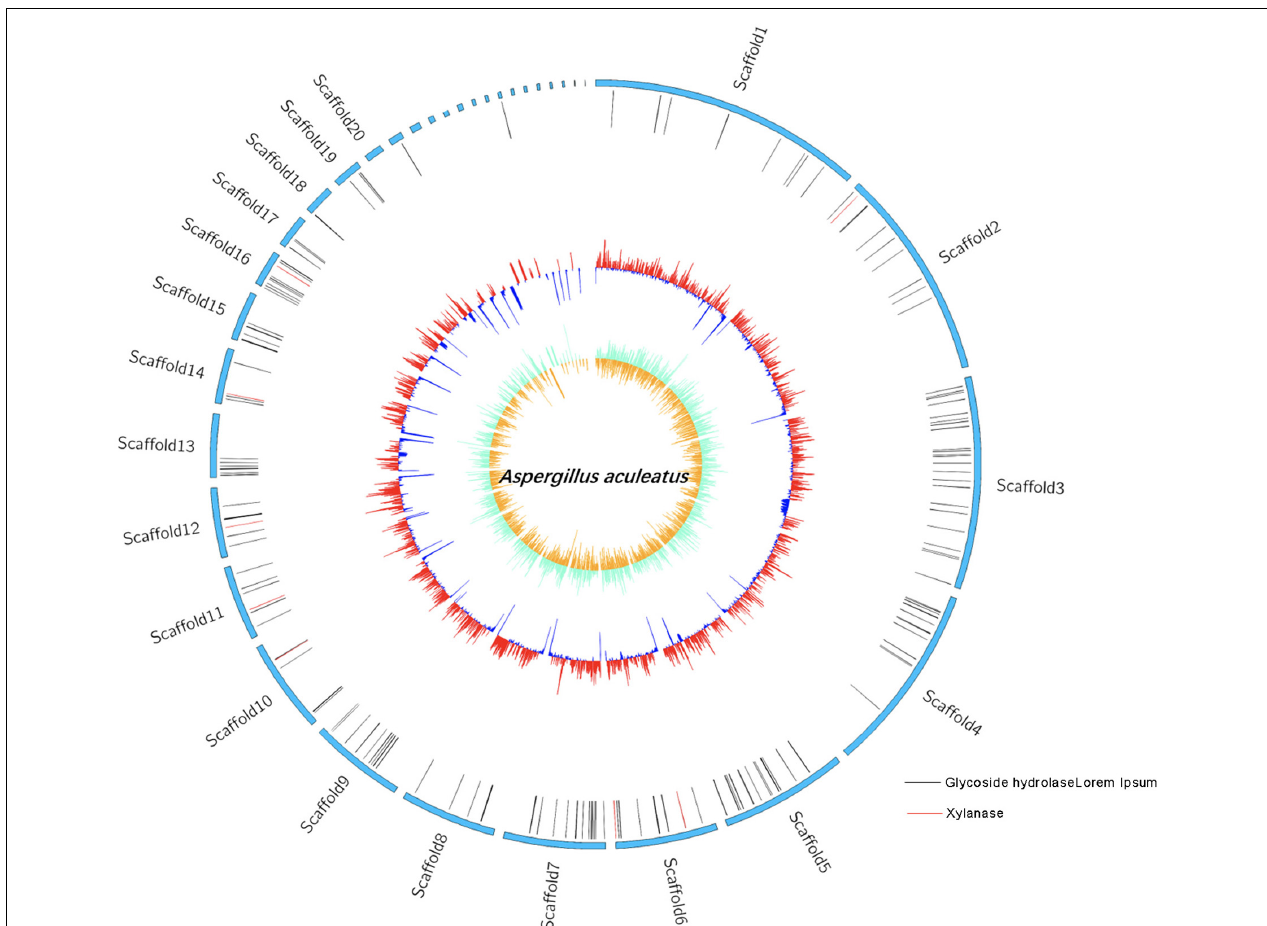
FIGURE 2 | Genome map of the